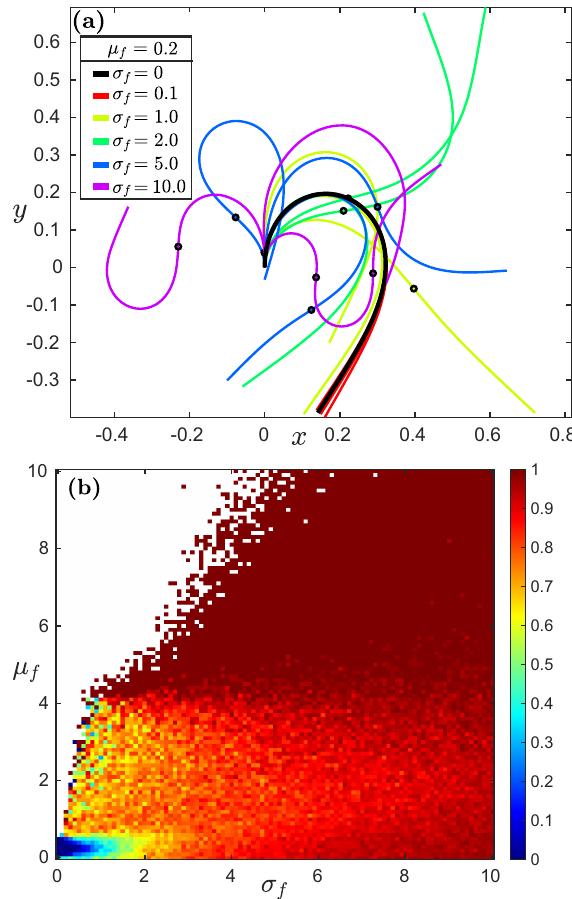
Figure 4. (a) Some examples of disordered realizations for dif- ferent values of σ f at a given value of µ f = 0 . 2. Open black circles represent the points on the fiber where curvature sign changes. (b) Relative proportion of fiber realizations whose cur- vature has changed at least once, as a function of ( µ f , σ f ). White regions correspond to self-intersecting